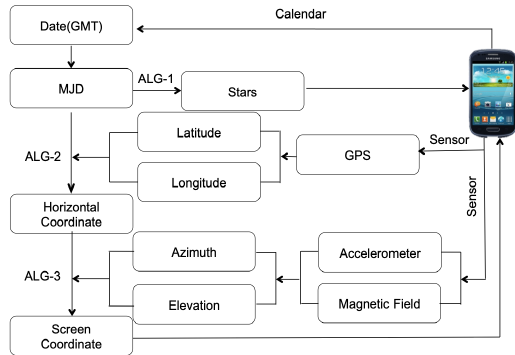
Figure 4. Procedure for calculating stars’ position in AR view.